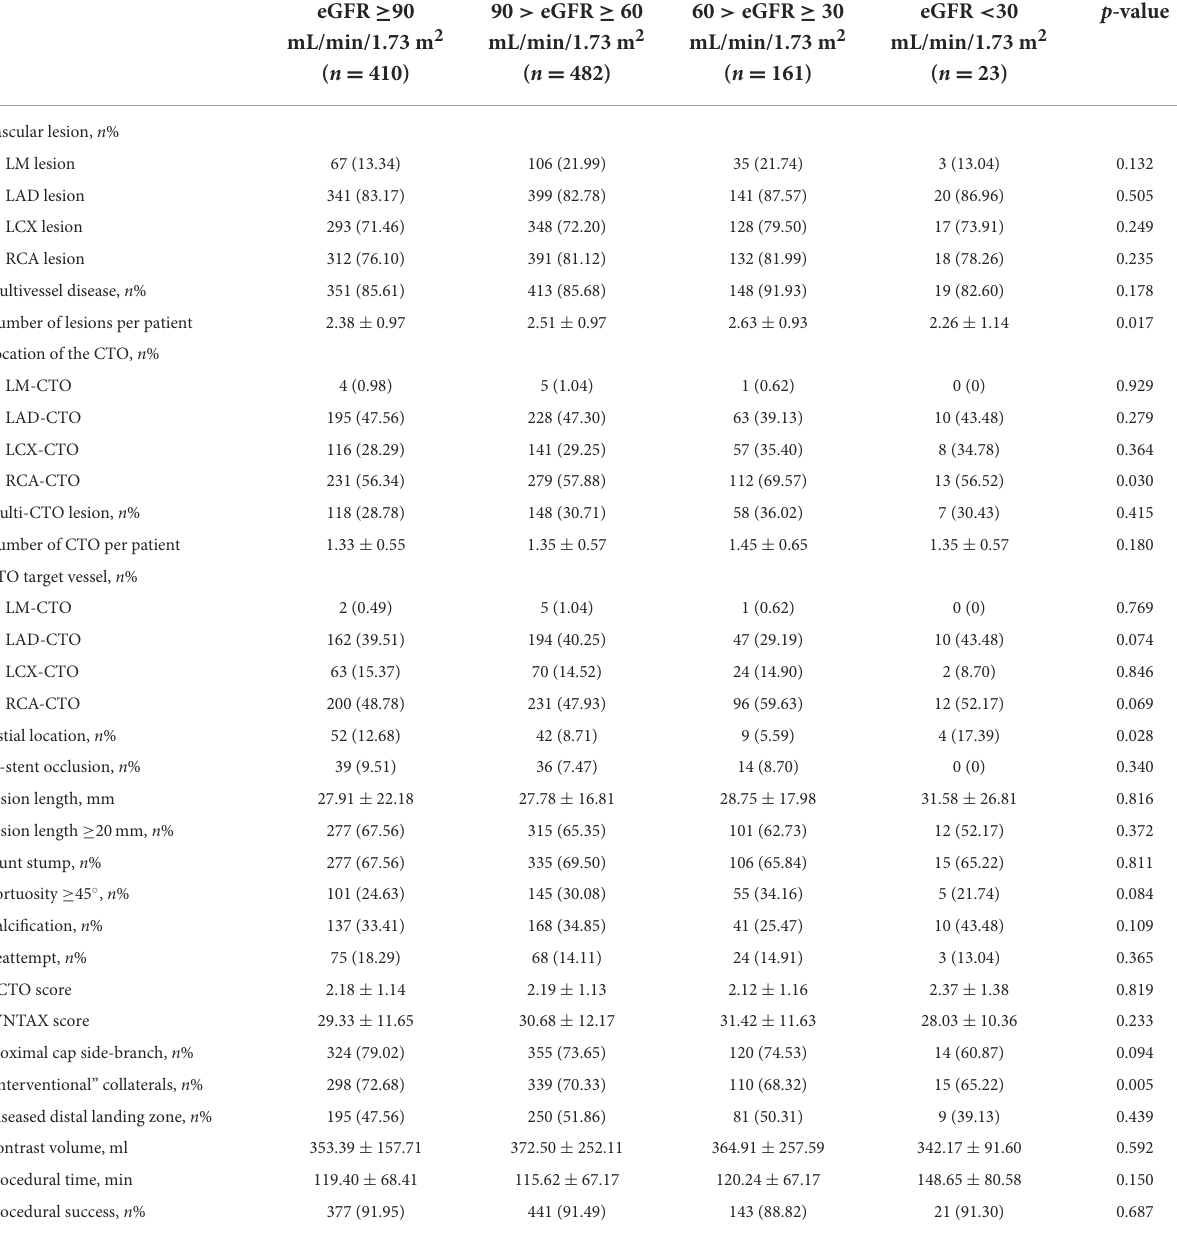
TABLE 2 Angiographic characteristics and procedural